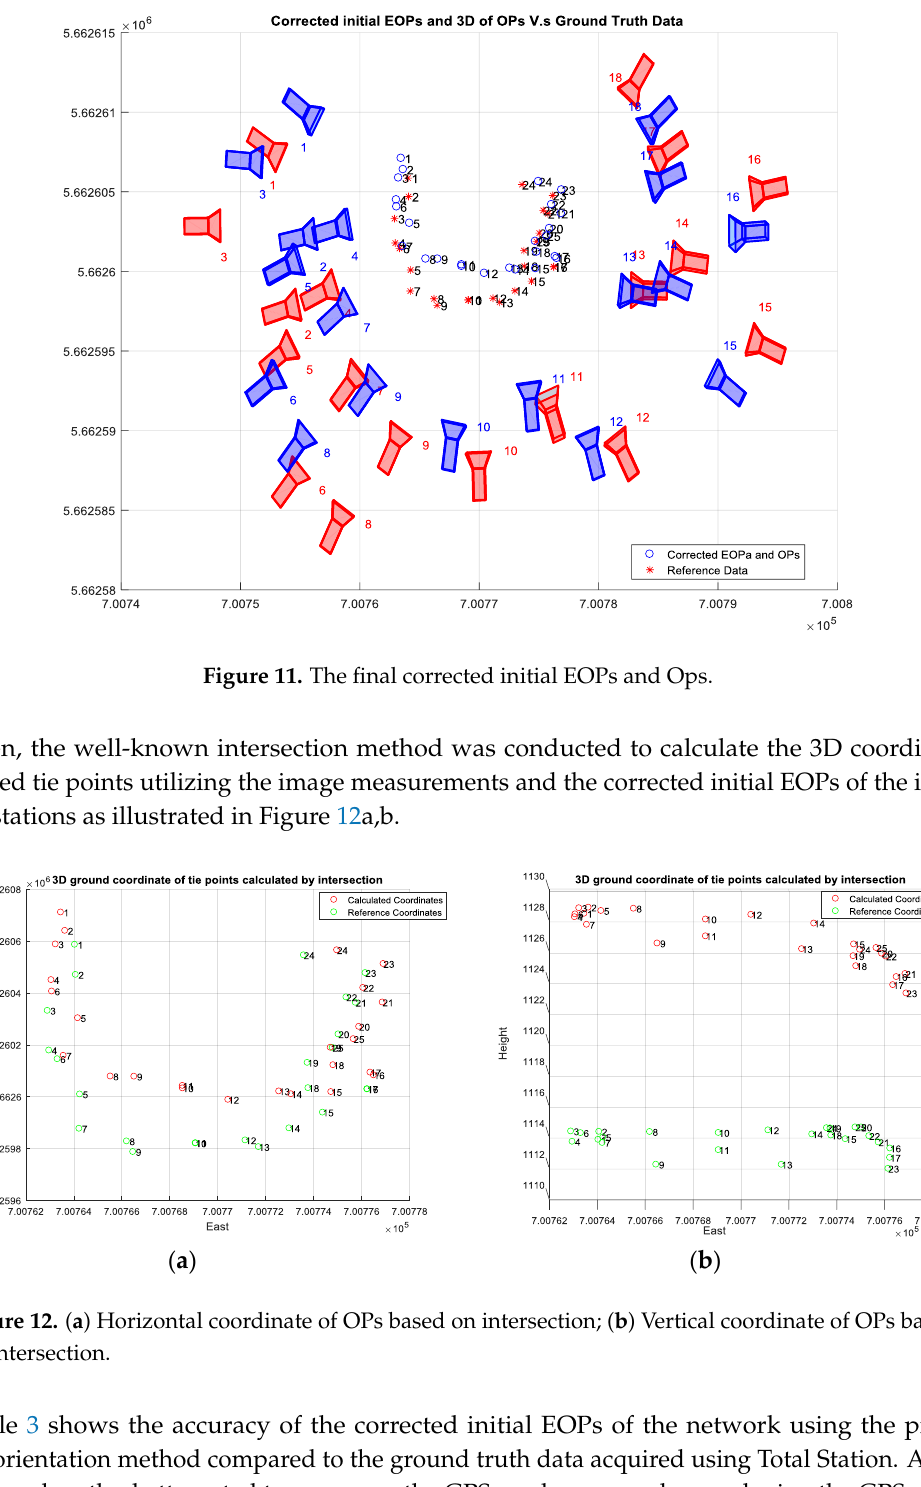
Figure 14. Residual at the final iteration.